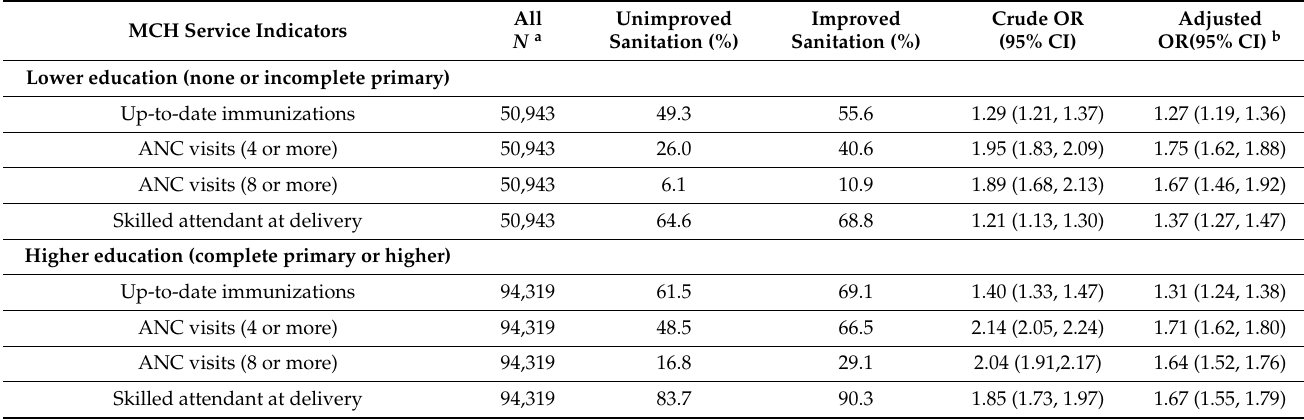
Table 5. Associations between improved (vs. unimproved) sanitation facilities and indicators of maternal and child health care service utilization, stratified by maternal education.